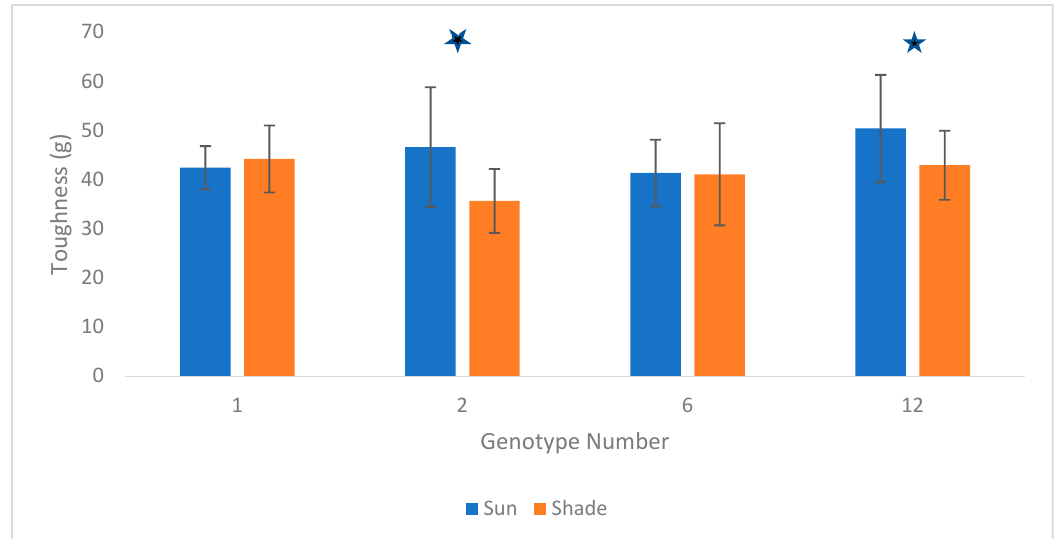
Figure 3. Average (+/ − standard deviation) toughness of sun vs. shade leaves in four different white spruce genotypes. The numbers 1, 2, 6, and 12 represent the different genotypes of clones chosen at the Arboretum for this study. Stars indicate the two genotypes for which significant differences between sun and shade foliage were observed.